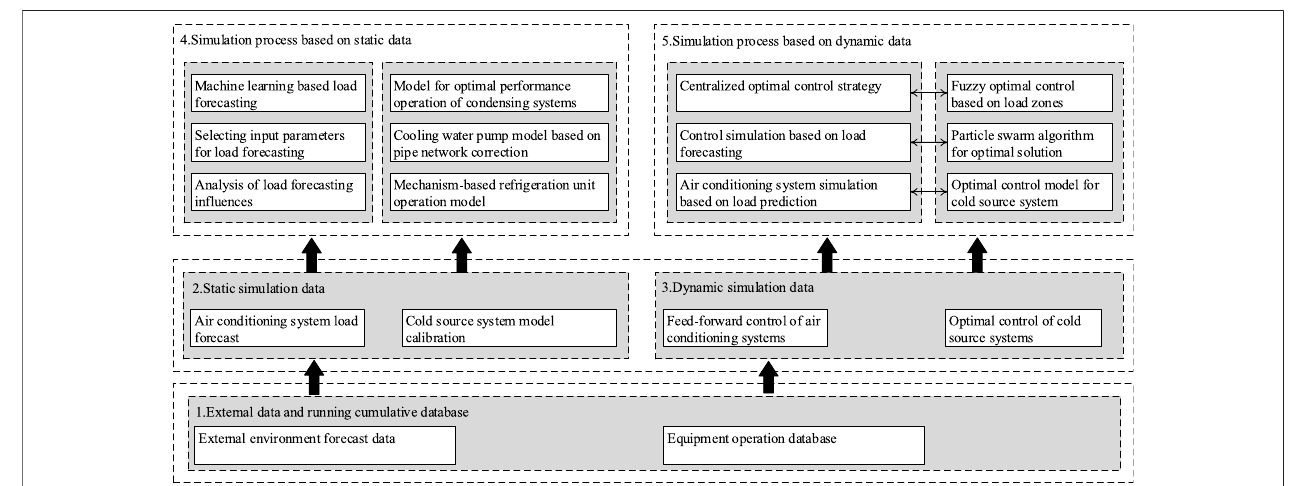
FIGURE 8 | Data simulation process of central air conditioning